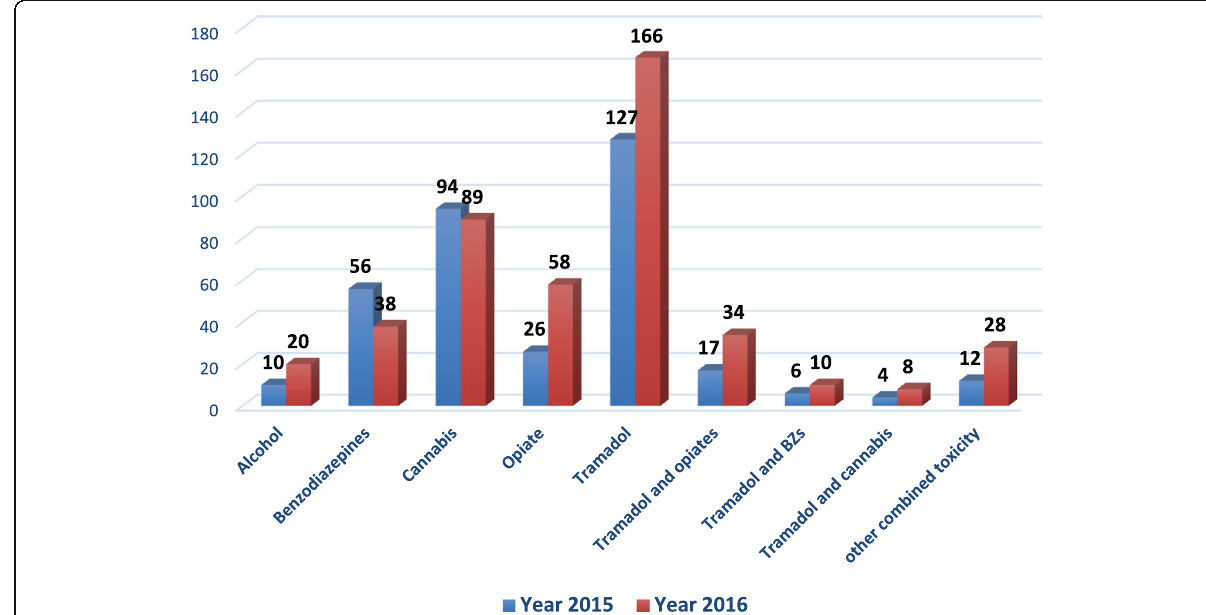
Fig. 2 Chart showing the correlation between the type of the drug and the studied